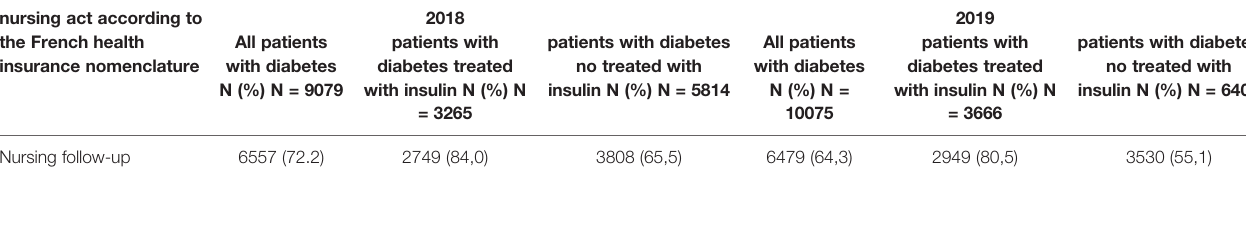
TABLE 4A | Distribution of nursing procedures according to the nomenclature of health insurance procedures and according to the insulin therapy of patients with diabetes. nursing act according to the French